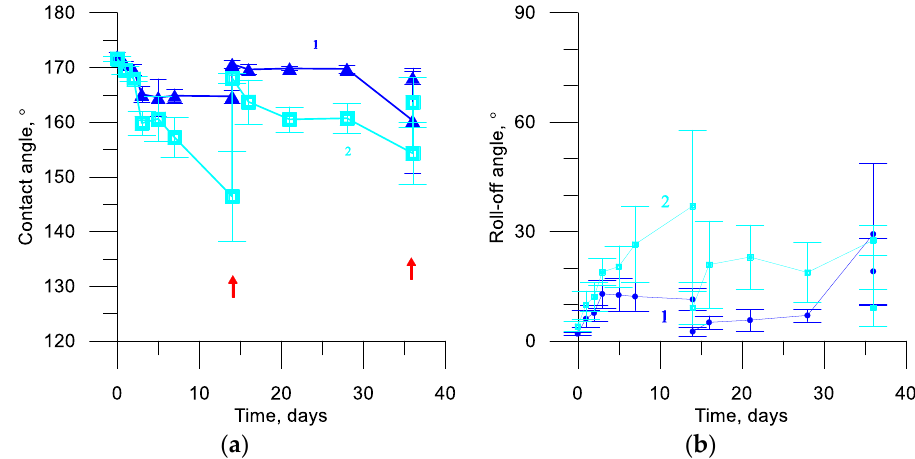
Figure 2. The variation of the water droplet contact angle ( a ) and roll-off angle ( b ) for two different superhydrophobic samples (1 and 2) subjected to continuous contact with 0.5 M NaCl for 36 days. The red arrows indicate the times (14 and 36 days) when the samples were washed with values given for both prior and after washing.